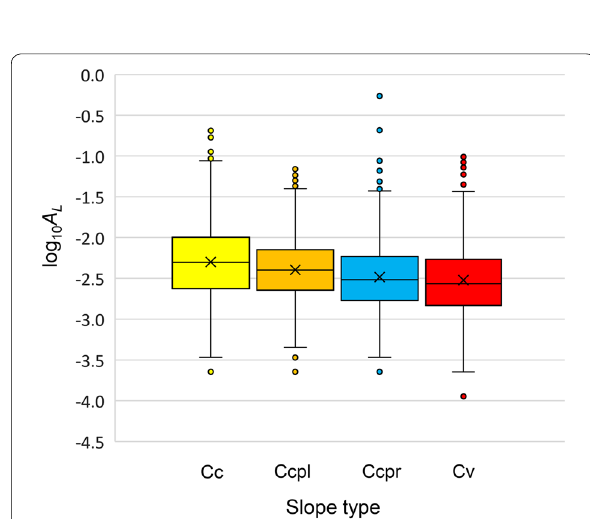
Fig. 14 Box plots of the logarithm of landslide area ( A L , km 2 ) with average landslide slope angle. The interquartile range is represented by the box. Upper whiskers are maximum values 1.5 times the ≤ interquartile range from the top of the box. Lower whiskers are minimum values 1.5 times the interquartile range from the bottom ≥ of the box. Outliers are plotted as dots. The horizontal line represents the median landslide area. The average landslide area for each slope type is also